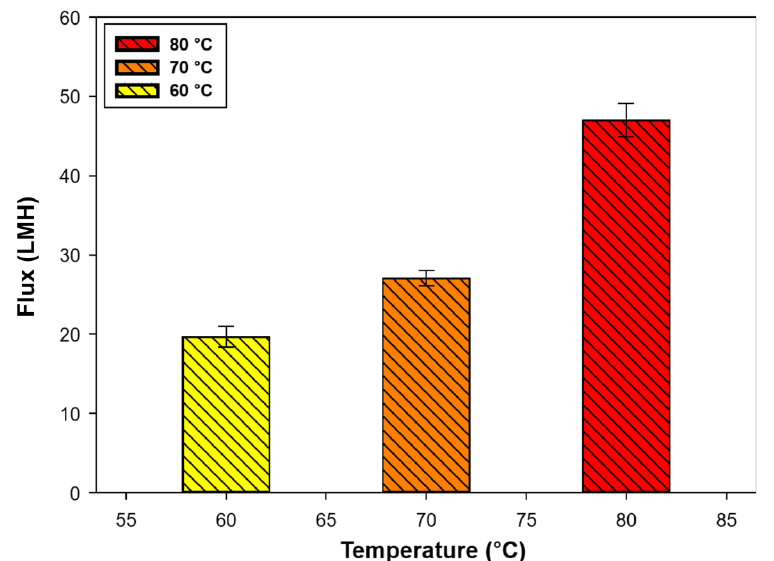
Figure 4. Baseline test results. Water fluxes at feed temperatures of 60, 70, and 80 °C (permeate temperature was maintained at 20 °C, and feed and permeate flow rates were 1.0 L min −1 ).